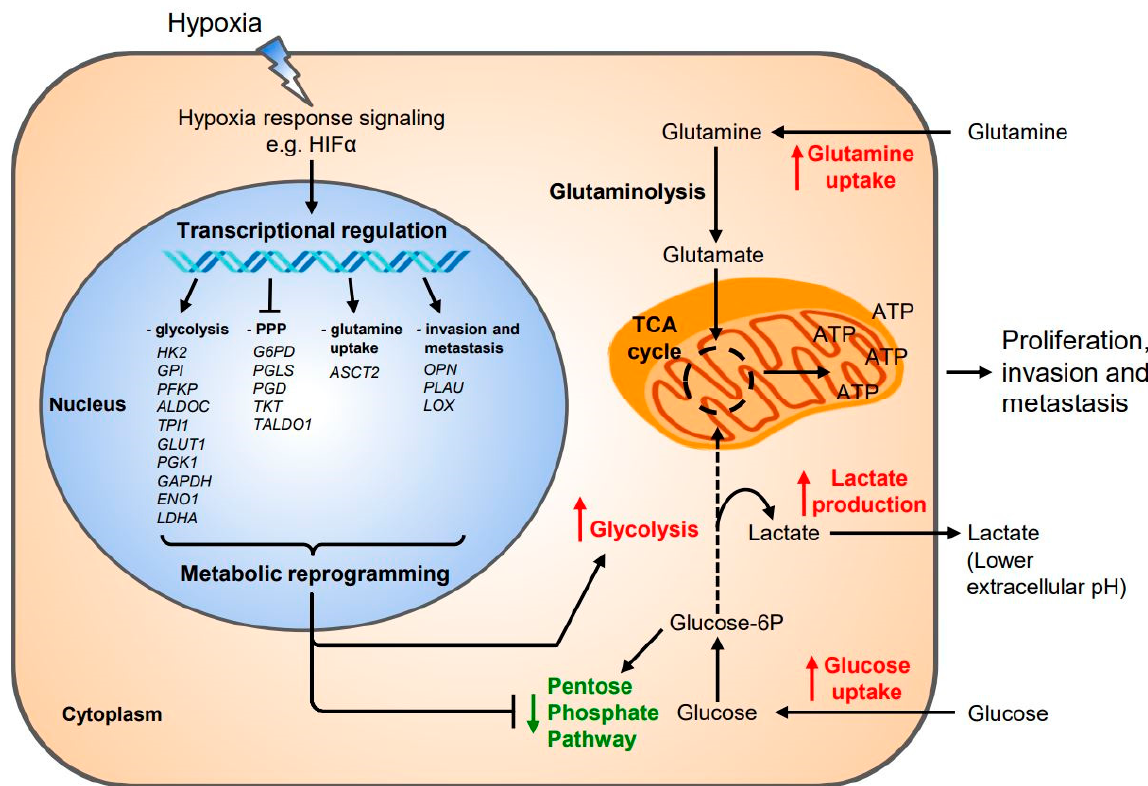
Figure 2. The Transcriptional-Metabolic Interactions under Hypoxia. A variety of genes upregulated transcriptionally under hypoxia affect cancer cell metabolism and behavior. The balance of glycolysis and oxidative phosphorylation along with the amounts of cholesterol, triacylglycerols, and other metabolites can metabolically “prime” a cancer cell to seed at specific organs during metastasis. HK2: Hexokinase 2; GPI: Glucose-6-phosphate isomerase; PFKP: 6-phosphofructokinase platelet type; ALDOC: Aldolase C; GLUT1: Glucose transporter protein type 1; PGK1: Phosphoglycerate kinase 1; GAPDH: Glyceraldehyde-3-phosphate dehydrogenase; ENO1: Enolase 1; LDHA: Lactate dehydrogenase-A; G6PD: Glucose-6-phosphate dehydrogenase; PGLS: 6-phosphogluconolactonase; PGD: 6-phosphogluconate dehydrogenase; TKT: Transketolase; TALDO1: Transaldolase 1; ASCT2: Alanine-serine-cysteine transporter, type-2; OPN: Osteopontin, PLAU: Plasminogen activator urokinase receptor, LOX: Lysyl oxidase; UPR: Unfolded protein response; TCA: Tricarboxylic acid; ATP: Adenosine triphosphate.